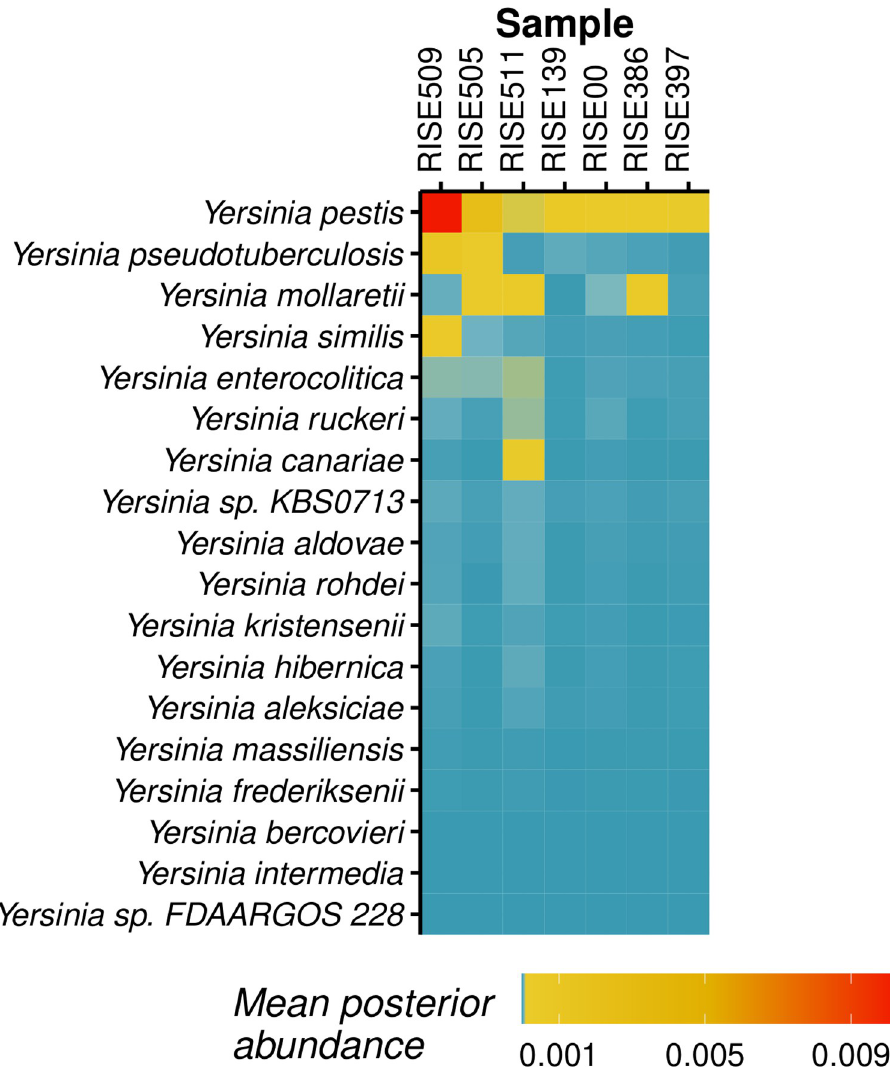
Fig 8. Posterior abundances of Yersinia species in Case Study 1. Heatmap showing the mean posterior abundances for the seven RISE samples, based on a genus specific analysis of 18 Yersinia species. Yersinia pestis is the species with the highest posterior abundance, followed by Y . pseudotuberculosis , in agreement with the results of (Rasmussen et al.,